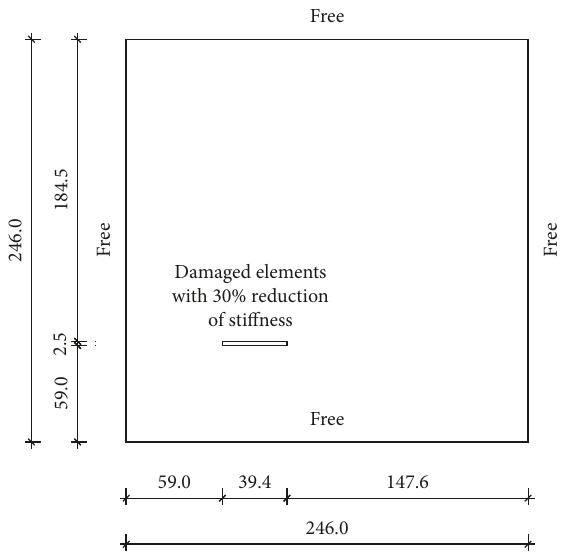
Figure 6: Free boundary square plate with a